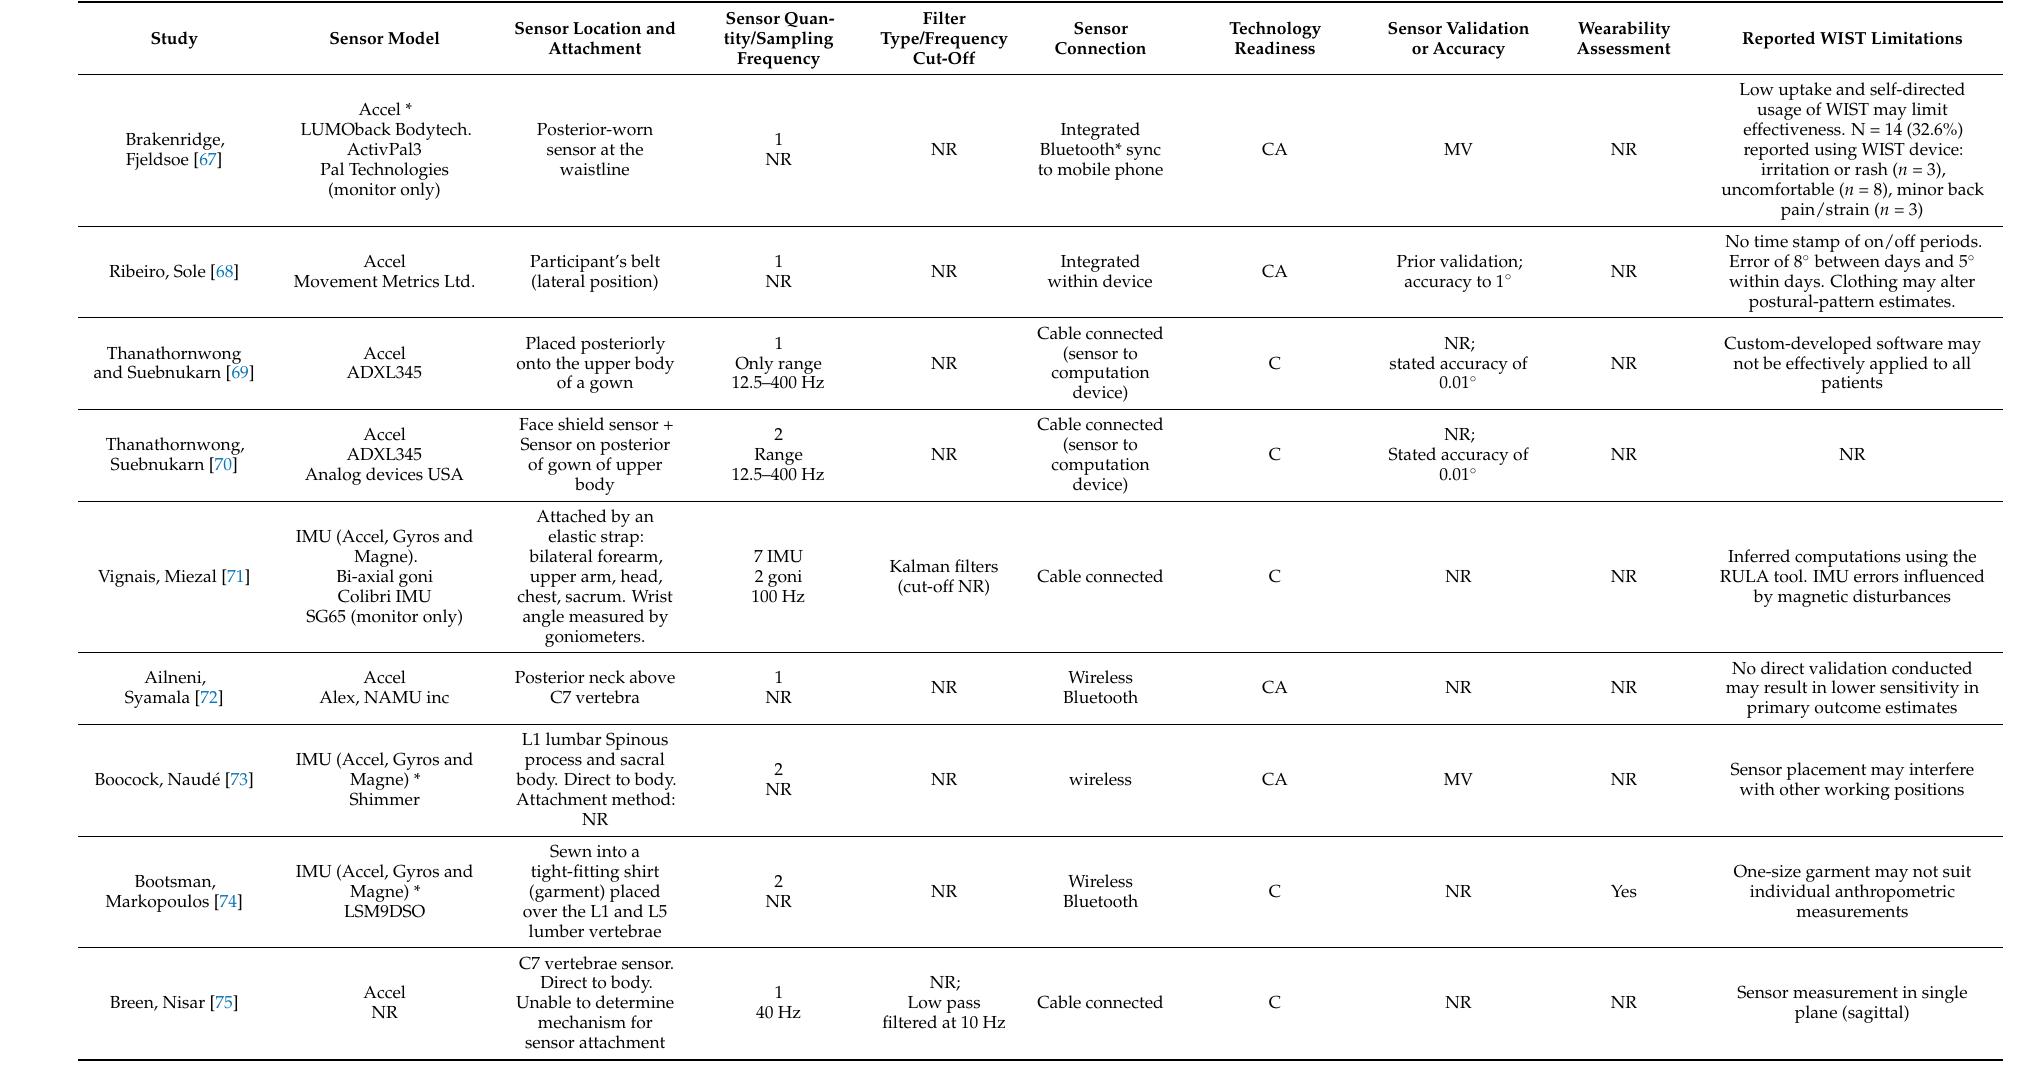
Table 5. Wearable inertial sensor technology (WIST) system characteristics used in each of the included